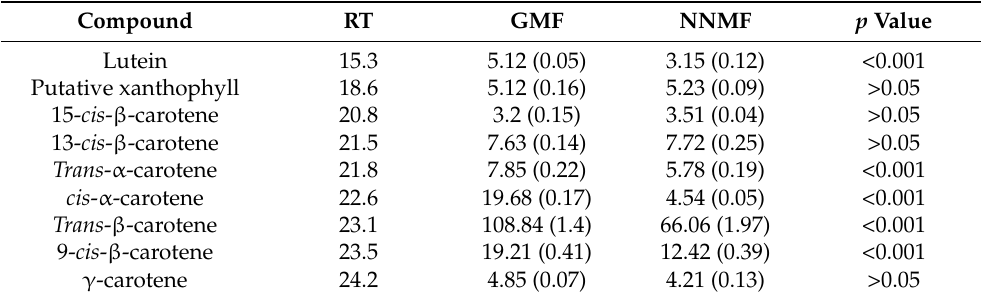
Table 2. Chemical characterization of Lima bean carotenoids in plants exposed to GMF and NNMF conditions. Values are expressed as µ g g − 1 F.Wt (standard deviation). p value refers to differences in carotenoid content between GMF- and NNMF-exposed